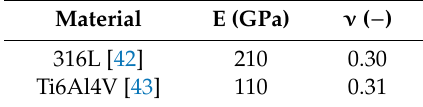
Table 4. Material properties considered in present work.